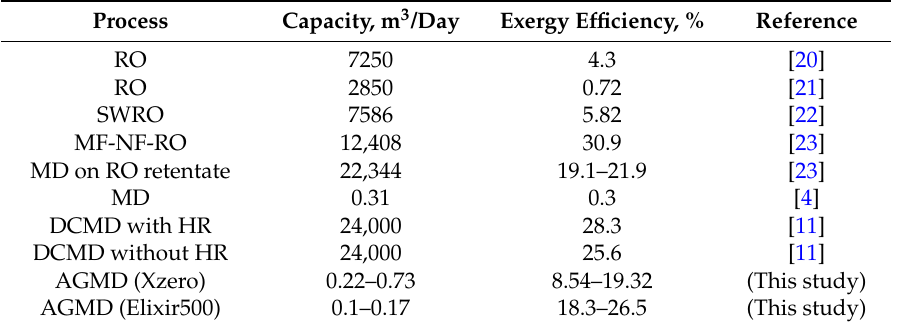
Table 2. Summary of exergy efficiencies for different MD configurations and RO from the